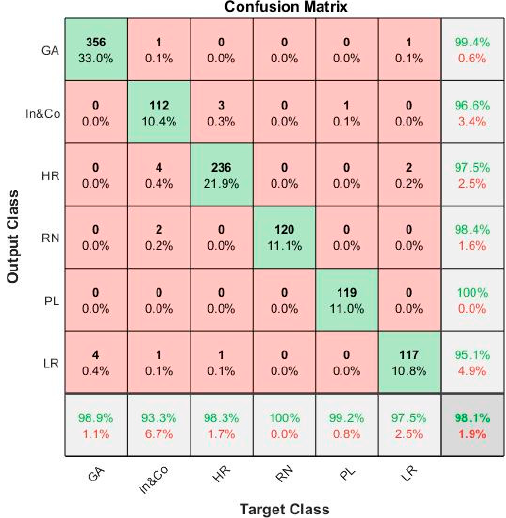
Figure 7. Confusion matrix for the highest performing GoogLeNet-‘pool5-drop’-SVM. GA, green area; In&Co, industrial and commercial areas; HR, high-density residential areas; LR: low-density residential areas; PL: parking lot; RN: road network.